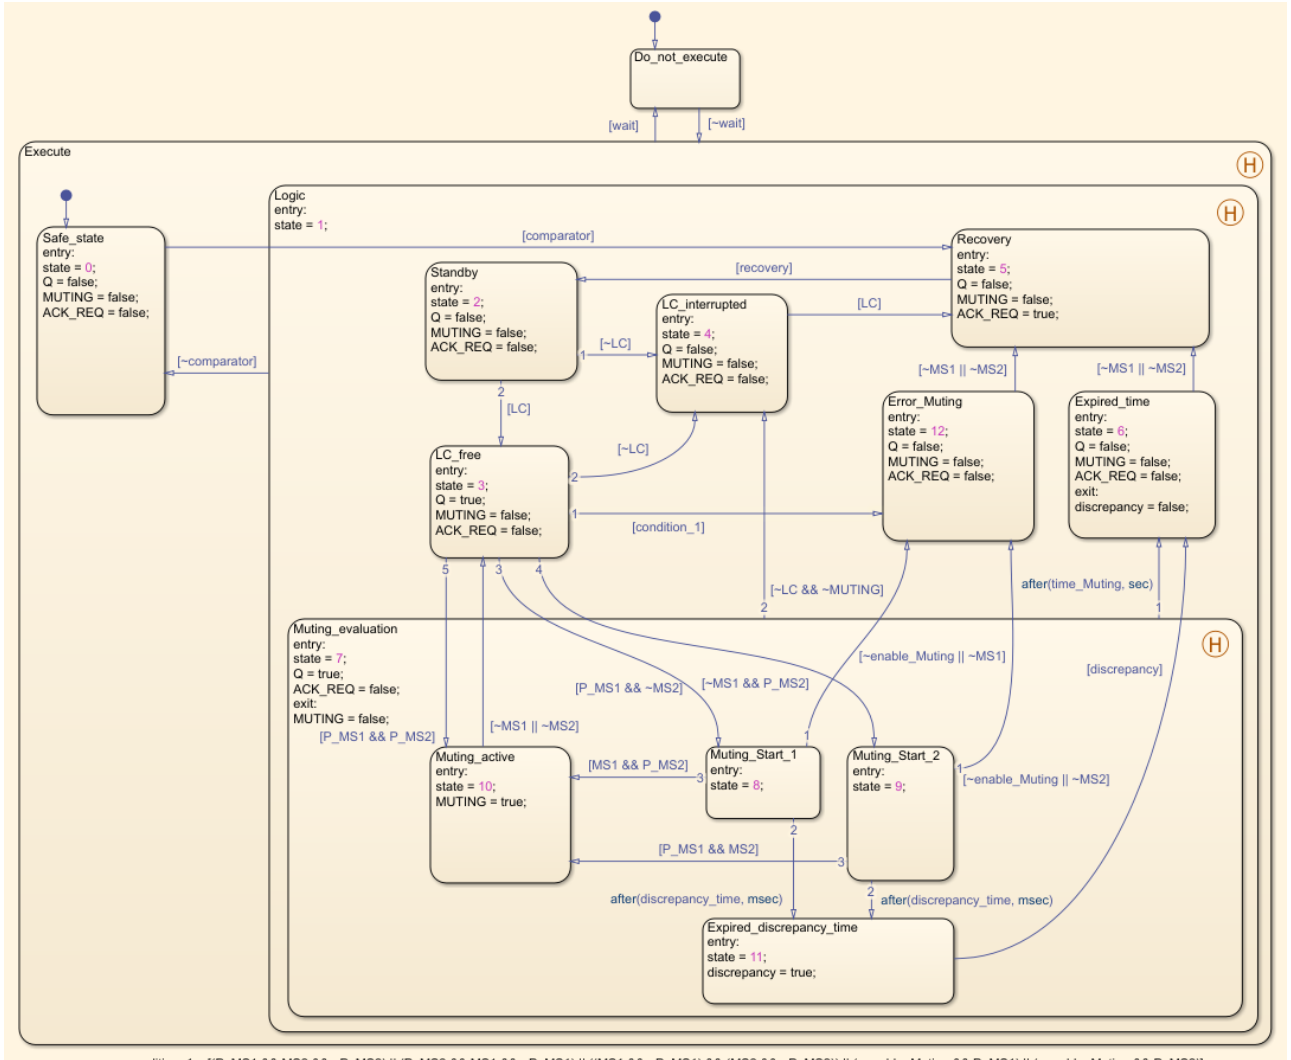
Figure 6. State diagram of the “Muting” safety function .